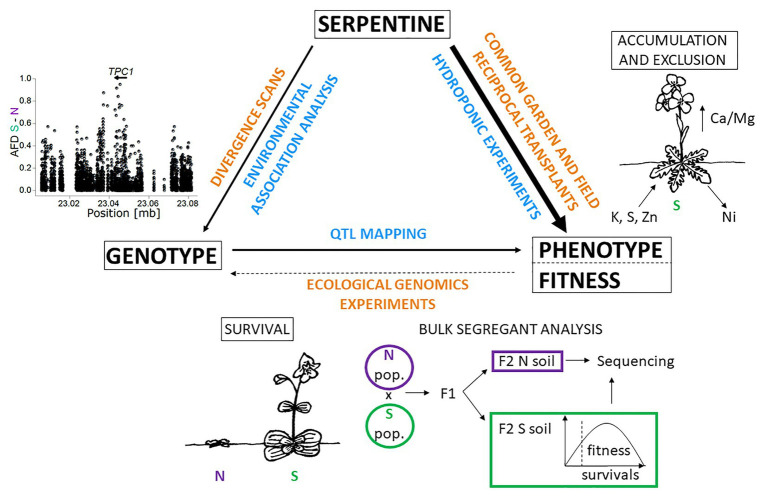
Approaches to study the basis of serpentine adaptation: Integration of holistic (orange) and one factor/hypothesis driven approaches (blue) to investigate links between genotype, phenotype, fitness, and serpentine environments. The right side of the triangle depicts ionomic analysis of Arabidopsis arenosa (Arnold et al., 2016), the bottom side is accompanied by the scheme of bulk segregant analysis applied in the recent study of Mimulus guttatus (Selby and Willis, 2018), and the left side is supplemented with allele frequency difference graph (AFD) of S and N population for TPC1 locus Arnold et al. (2016). Line thickness scales with the quantity of empirical studies available. S – serpentine adapted plant, N – non-serpentine plant. The scheme is inspired by Sork et al. (2013) and Rellstab et al. (2015). Illustrations by V. Konečná.